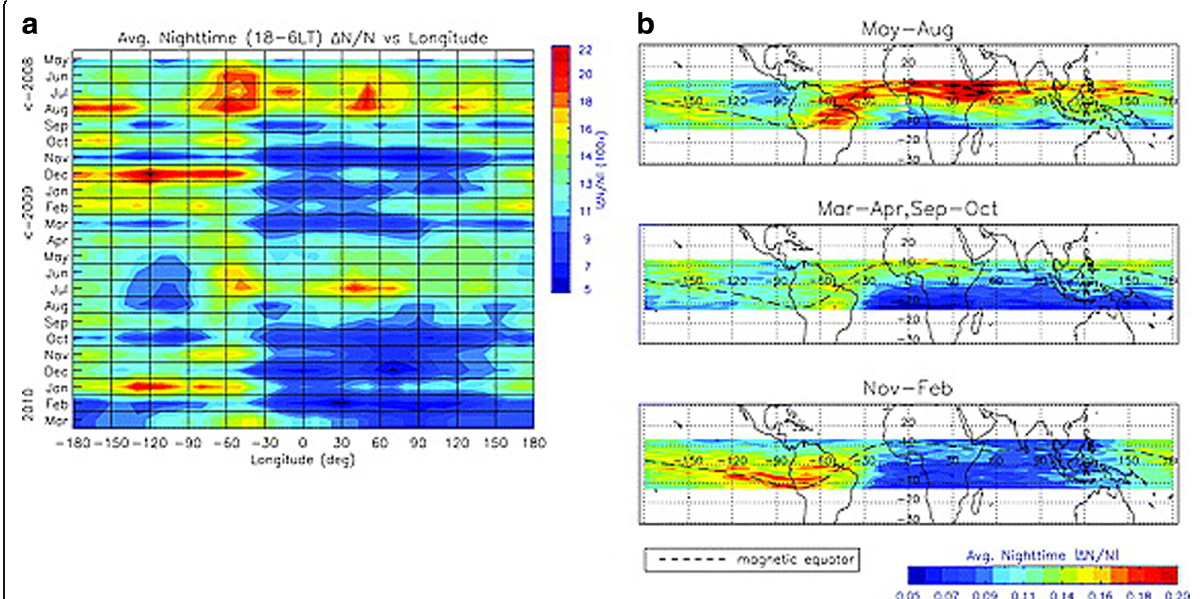
Fig. 4 a Average nighttime Δ N / N versus longitude over time from May 2008 to March 2010. b Average nighttime Δ N / N separated by seasons from observations dated May 2008 to March 2010 (after Dao et al.